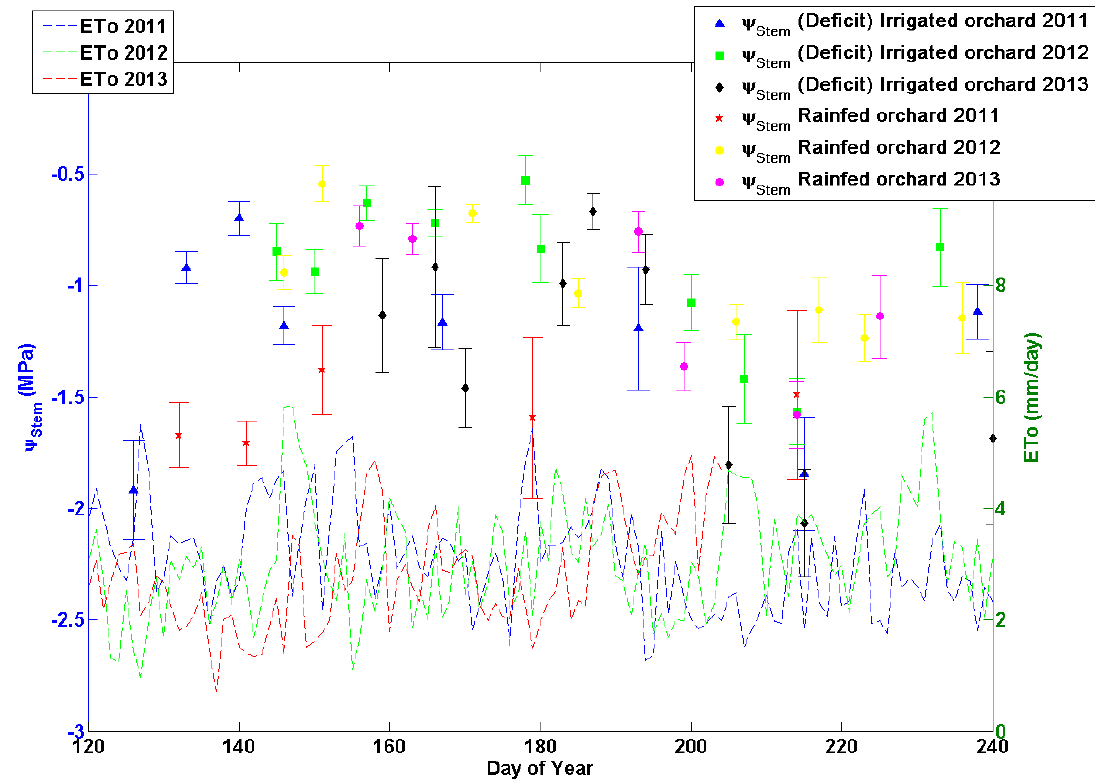
Figure 1. Reference evapotranspiration (ETo; mm/day) from Beauvechain, Belgium, and measured stem water potential ( Ψ ; MPa), averaged for all plots in both the (deficit) stem irrigated and rainfed orchard, with bars indicating standard